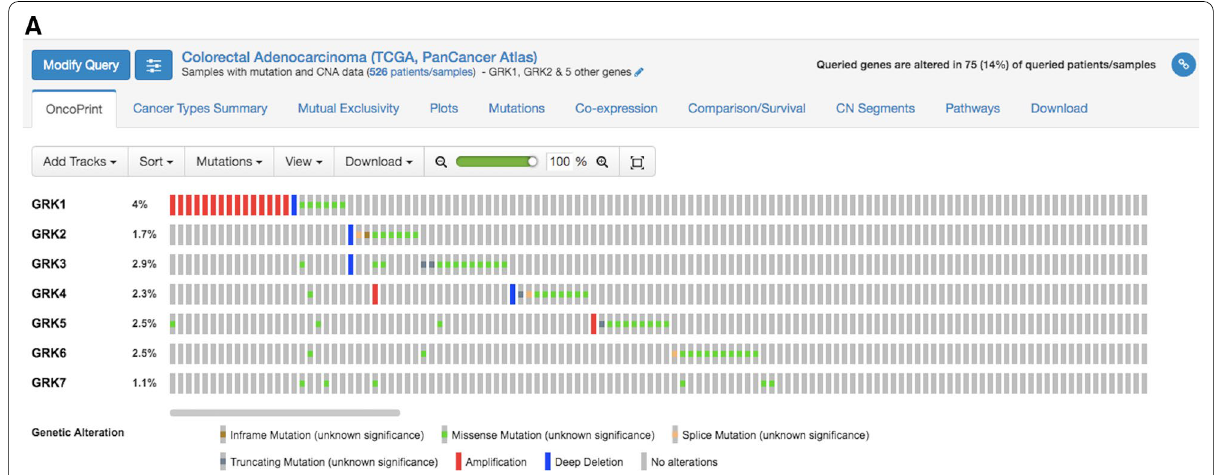
Fig. 3 A Oncoprint analysis of GRK family genes across colorectal adenocarcinoma samples from TCGA study as analyzed by cBioportal. B Mutation profile of GRK family genes across colorectal adenocarcinoma samples from TCGA study as analyzed by